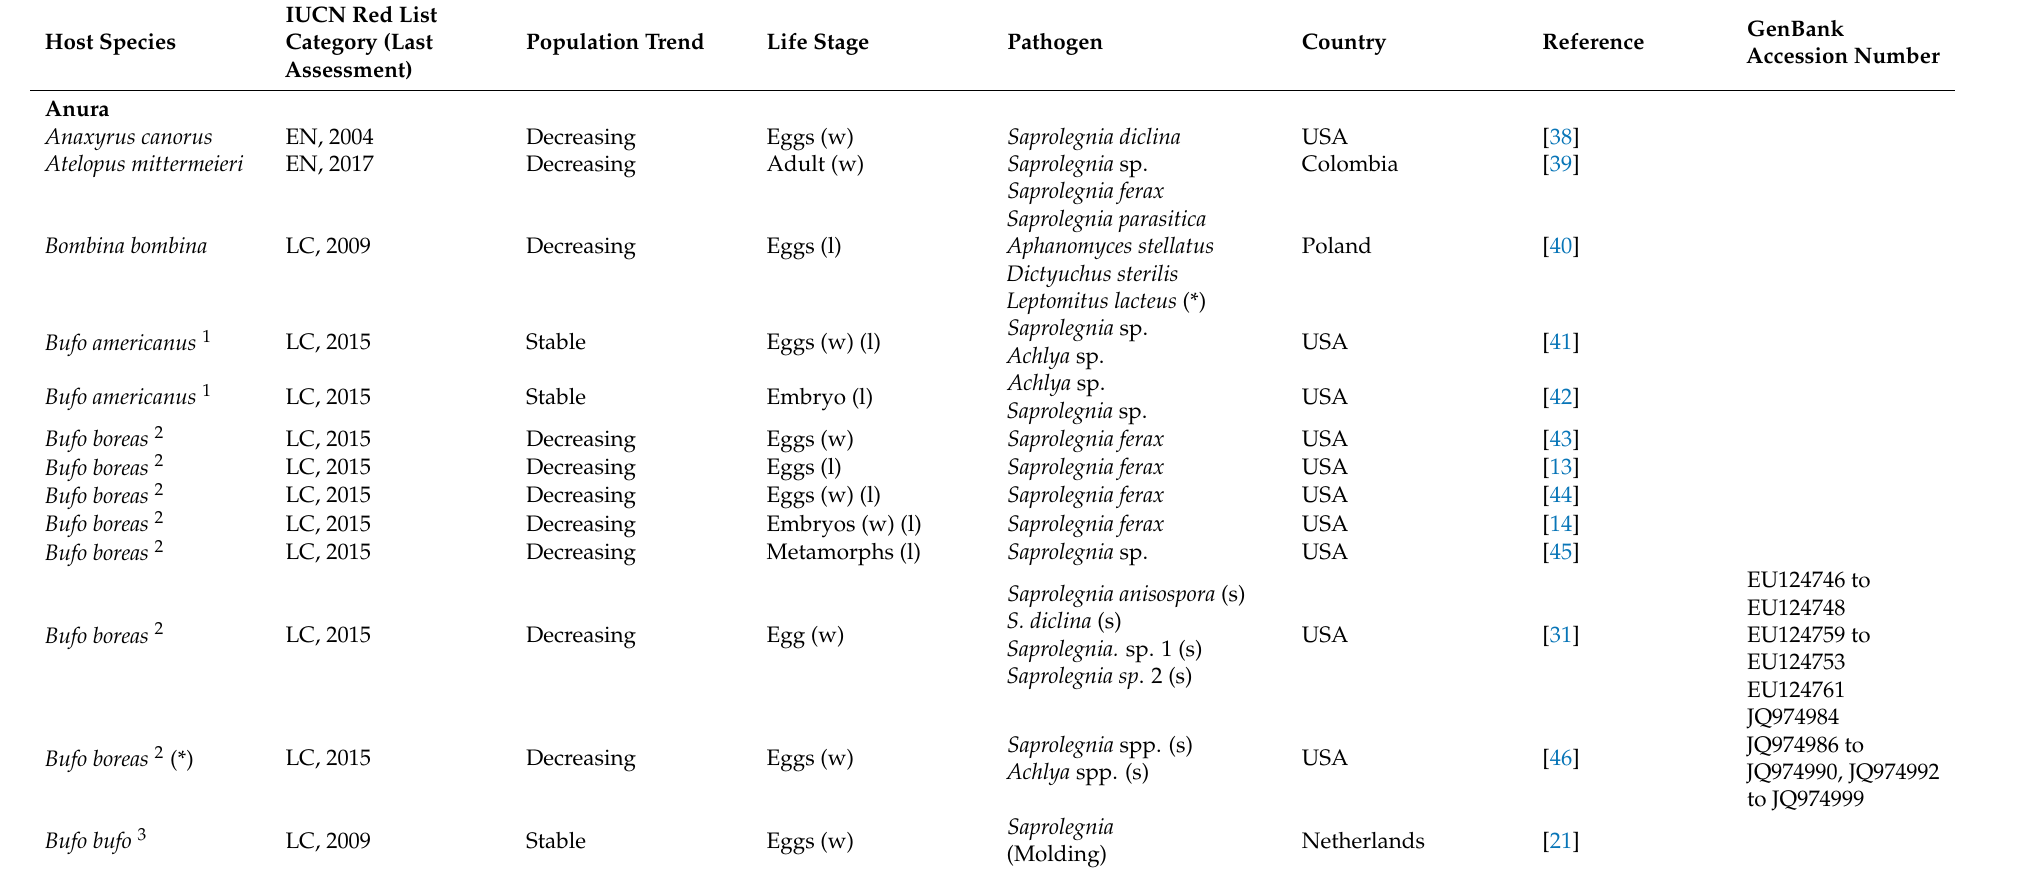
Table 1. Studies reporting the occurrence of saprolegniosis in different life stages of amphibians. Whenever possible, the pathogen is indicated accordingly as identified in the original publication. (s)—identification based on phylogenetic analyses; w—reported in the wild; c—reported in captivity; l—laboratory assays (infection during laboratory assays, or artificially exposed for susceptibility assay or for assessing exposure effects to the pathogen); n.d.—not defined. Note: The scientific name of the host species is indicated as it appears in the original publication. IUCN Red List Category: Least Concern (LC); Near Threatened (NT); Vulnerable (VU); Endangered (EN); Critically Endangered